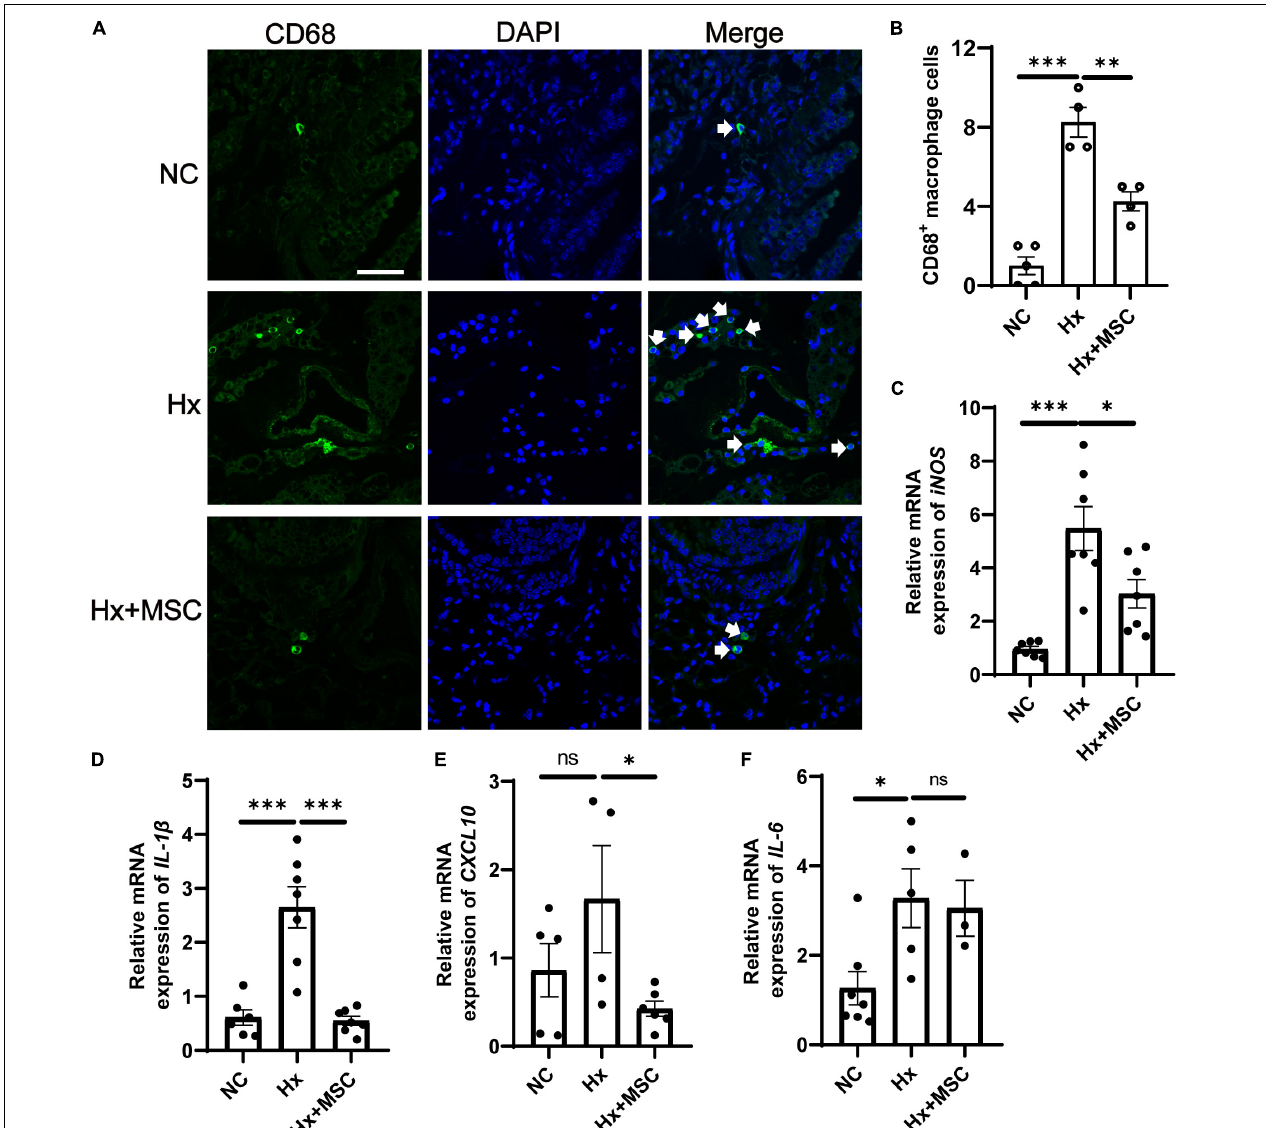
FIGURE 6 | Administration of MSC reduces inflammation in hypoxia-induced PH. (A) Immunofluorescence images of DAPI (blue) and CD68 (green) expression in hypoxia-induced mice treated with MSCs. White arrow: CD68 + macrophage. (B) , Quantification of CD68 + macrophages in the lungs of mice. A total of 10 fields of view per mouse were counted. ∗∗∗ P < 0.001. NC, Vehicle control; Hx, hypoxia-induced group; Hx + MSC, MSC-treated group. n = 4–5; Scale bars = 50 µ m. (C–F) The mRNA level of iNOS , IL-1 β , IL-6 , and CXCL10 in lung tissues from NC, Hx, MSC groups’ mice 21 days after corresponding treatment were detected